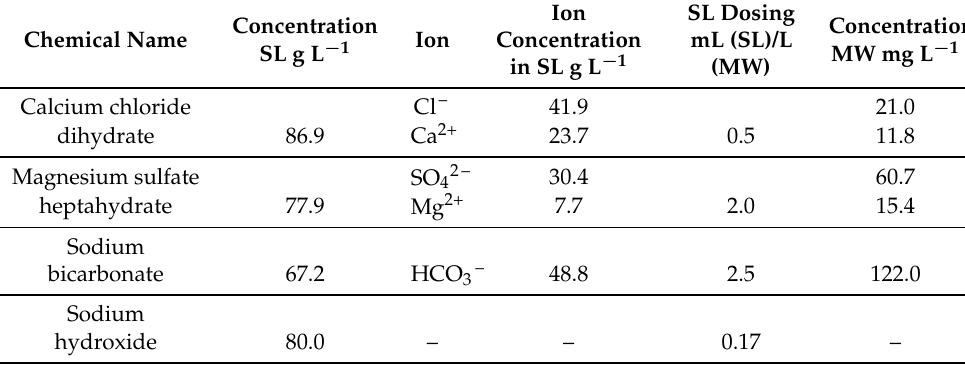
Table 9. F. Test water for pH value high—Experiment